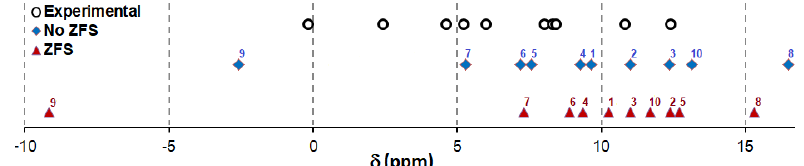
Figure 2. Experimental and computed pNMR spectra for [ NdL py ] 3 + with and without ZFS at 298.15 K. For numbering of protons see Figure